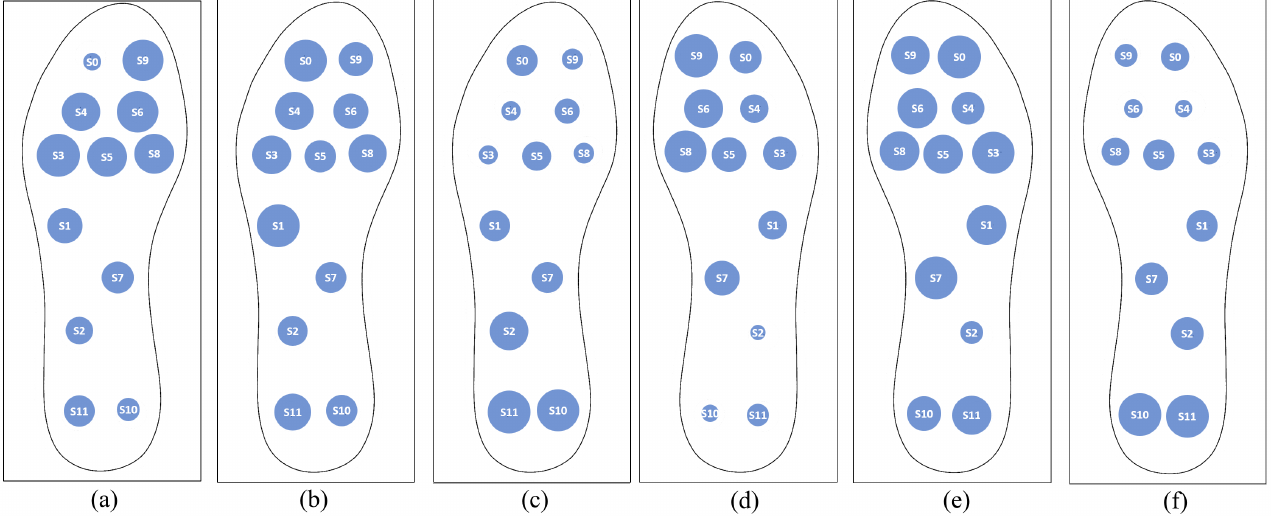
Figure 10. Map distribution samples obtained during different gait stages. For size EU 43 insole: ( a ) the forefoot is resting on the ground; ( b ) the whole foot is resting; ( c ) the hindfoot is resting. ( d – f ) reflects the same stages as ( a – c ), respectively, but with the size EU 38 insole.